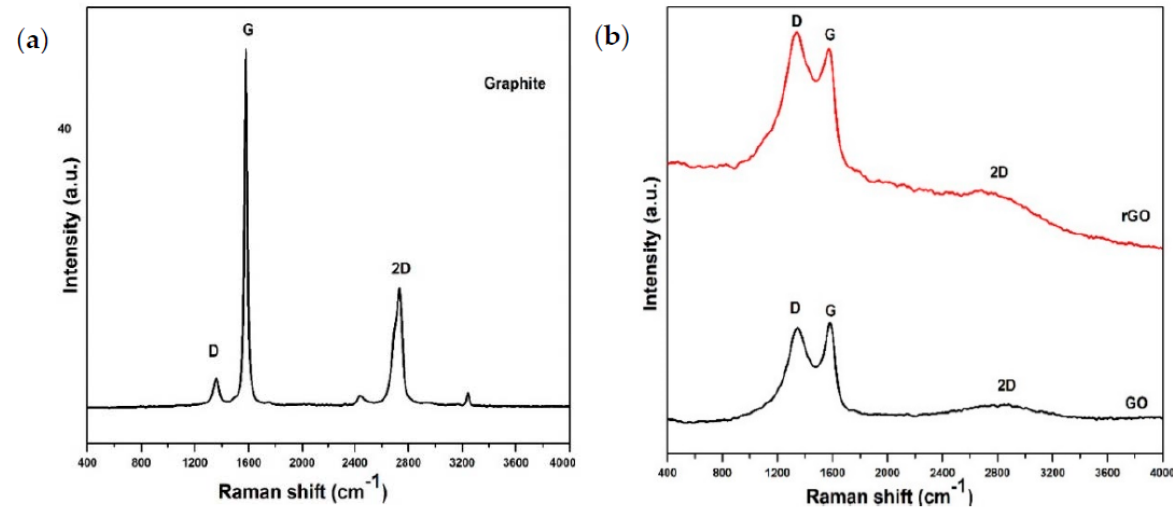
Figure 7. Raman spectrum of ( a ) Graphite and ( b ) GO and rGO. Table 3. D band, G band and D/G ratio from the Raman spectra of Graphite, GO and rGO.